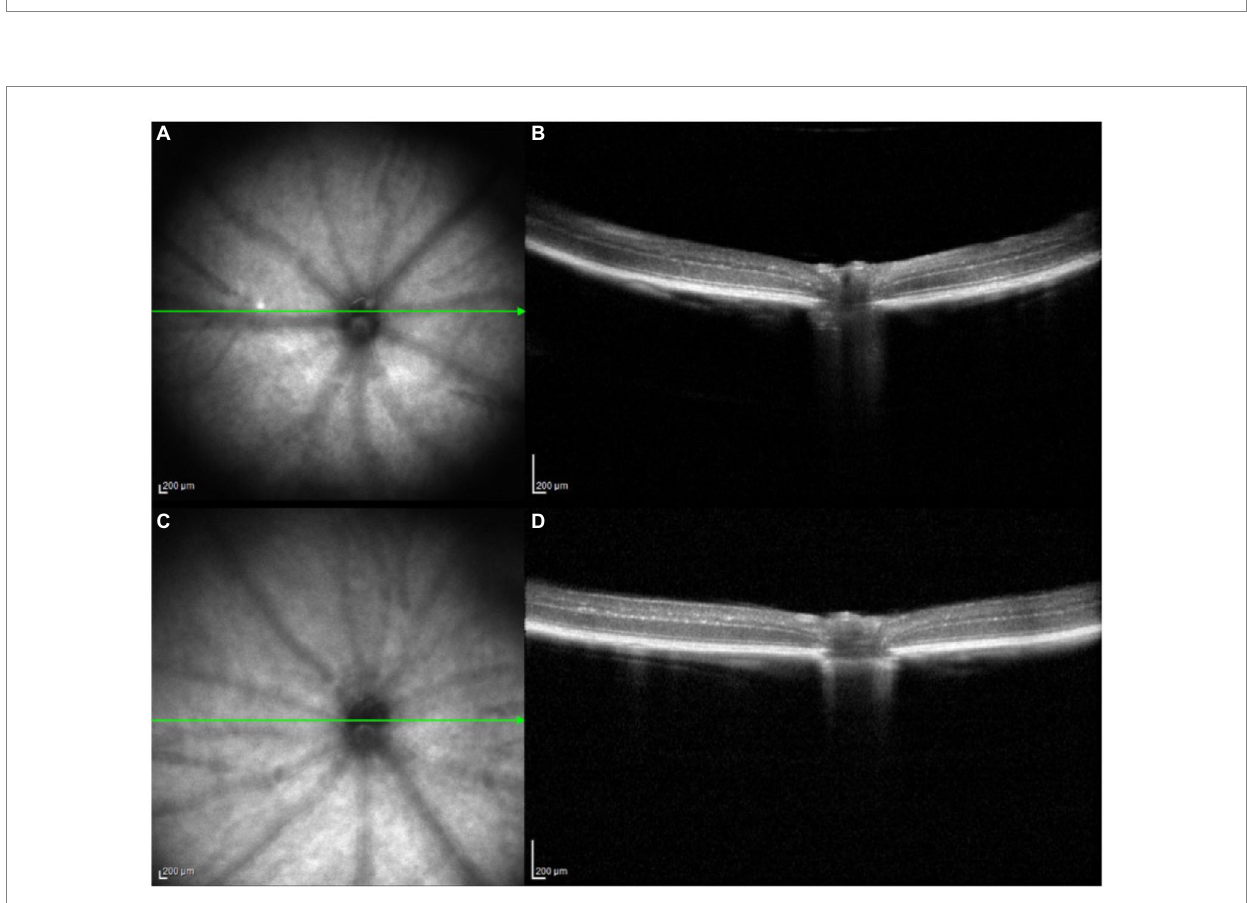
FIGURE 3 OCT images for the FDM-OD and FDM-OS. Notes: (A, B) : FDM-OD; (C, D) : FDM-OS. FDM: form-deprivation myopia; OD: oculus dexter; OS: oculus sinister; OCT: optical coherence